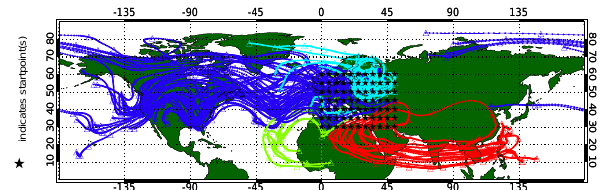
Fig. 11. The zonal acetone distribution of acetone (units of pptv) as a function of pressure for August 2003. Data are averaged into as a function of pressure for August 2003. Data are averaged into 10 ◦ latitude × 25hPa pressure boxes. White lines indicate potential 10 ◦ latitude x 25 hPa pressure boxes. White lines indicate potential temperature ( θ ) levels in Kelvin. White squares indicate regions temperature ( θ ) levels in Kelvin. White squares indicate regions where there are fewer than ten clear data points for the where there are fewer than ten clear data points for the month.